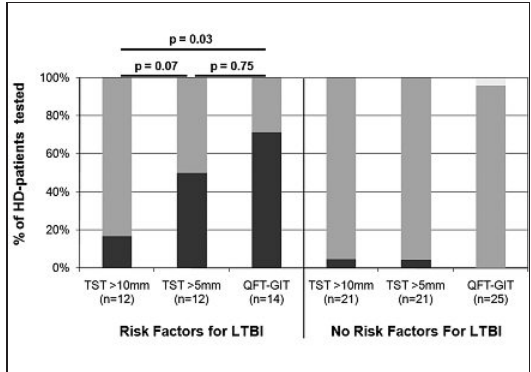
Association between TST (cut off 5 mm or 10 mm, respectively), QFT-GIT positivity and risk factors for LTBI. Dark